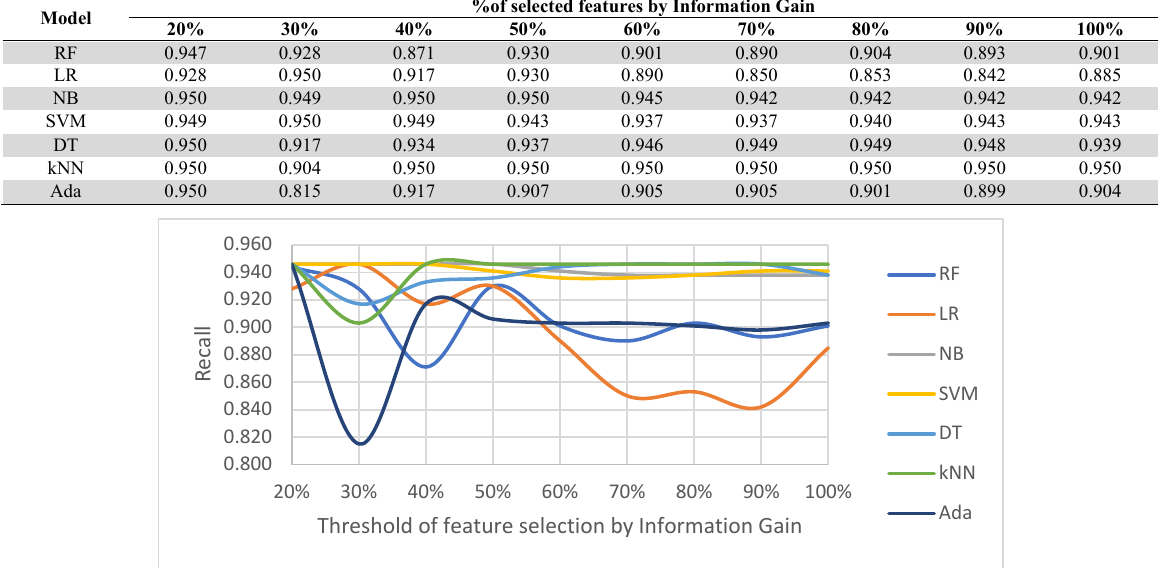
%of selected features by Information Gain